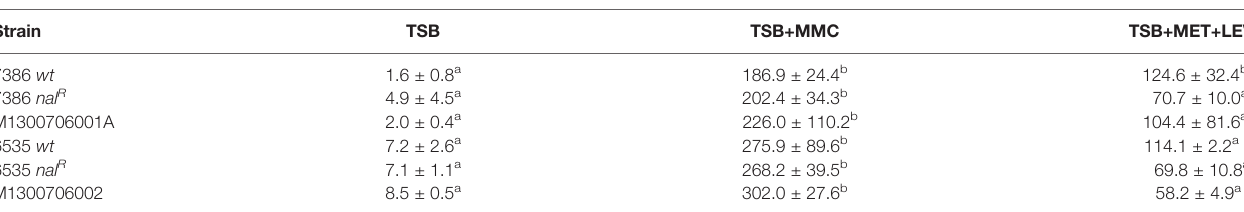
TABLE 4 | stx 2a gene expression of the different strains.